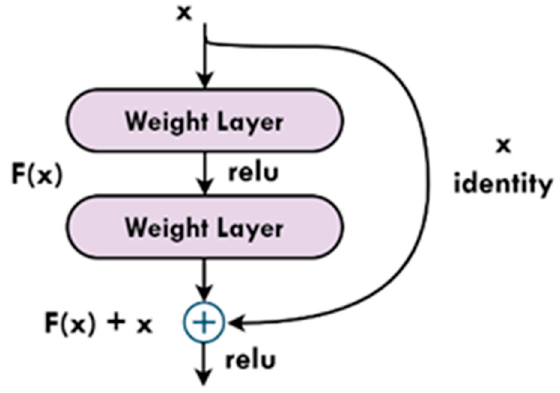
Figure 5. Skip connection (or residual block) as given by He et al., 2017 [29]. Other models train on the output ’Y’, but ResNet trains on F(X). ResNet tries to make F(X) = 0 so that Y = X.